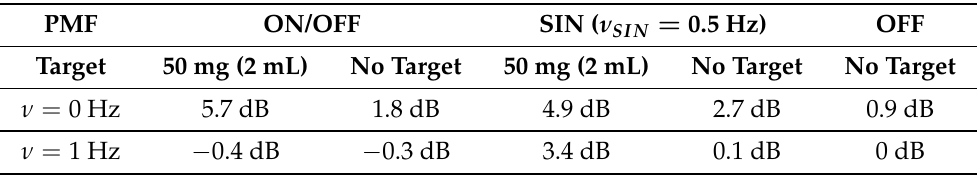
Figure 13. The 3D UWB images based on ON/OFF and SIN modulation of the PMF, as well as no presence of a PMF corresponding to Equations (25) and (26). DAS beamforming with the DC component | ∆ Y ONOFF ( t , ν = 0Hz, ∆ H m ,0 ) | ( a , b ) and | ∆ Y OFF ( t , ν = 0Hz, ∆ H 0,0 ) | ( c ) as the input signal, as well as the second harmonic | ∆ Y SIN ( t , ν = 1Hz, ∆ H m ,0 ) | ( d , e ) and | ∆ Y OFF ( t , ν = 1Hz, ∆ H 0,0 ) | ( f ) as input signal. ( a , d ) The 2 mL target with a concentration of 25mg/mL at position [ x , y , z ] = [ 0; − 3; − 3.5 ] cm. ( b , e ) ON/OFF and SIN modulation, respectively, without a target. ( c , f ) No presence of a PMF and without a target. The images are normalized to the maximum intensity of Subplot ( a ). Table 1. S / C ratio for ON/OFF and SIN modulation, as well as for the scenario without the presence of an external